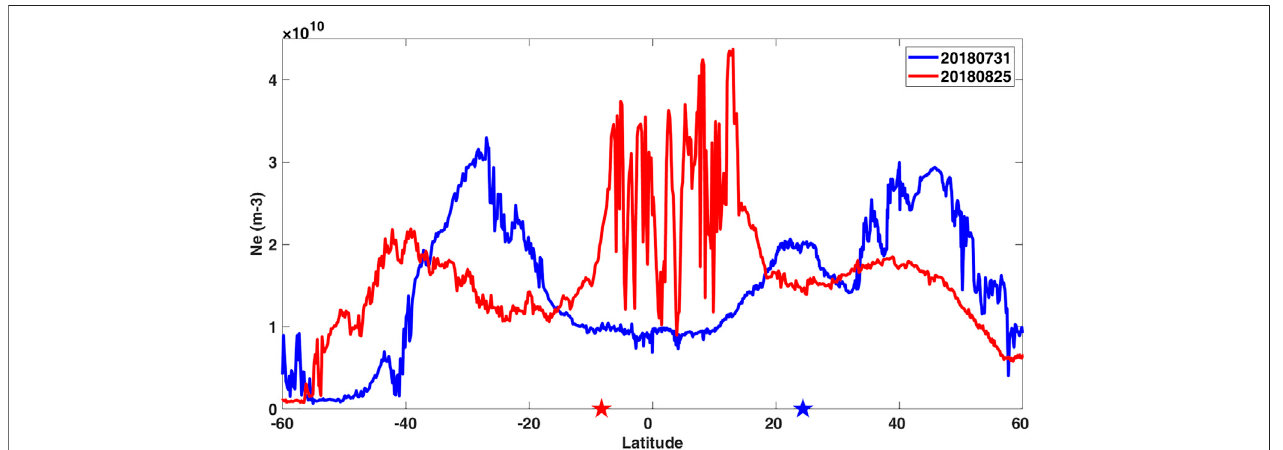
FIGURE 4 | Electron densities distribute along the latitude for two orbits in the nighttime. Blue line is on 31 July 2018. Red line is on 25 August 2018. Note that the Ne change aroundthemagneticequator fortheorbiton25August2018isaffectedbyEPB. Redand bluestars represent theepicenterofIndonesiaMw6.9 earthquake and its conjugate point,